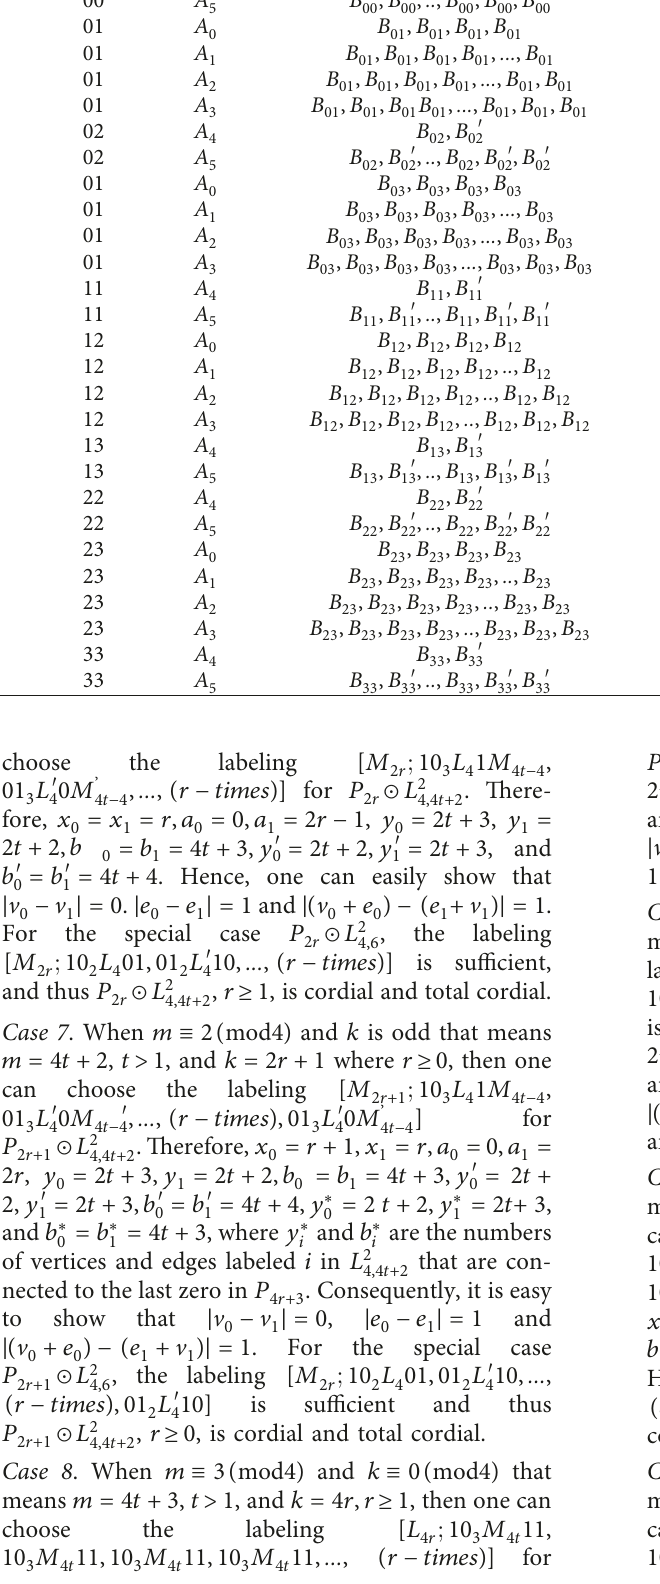
Table 3: Labelling of P